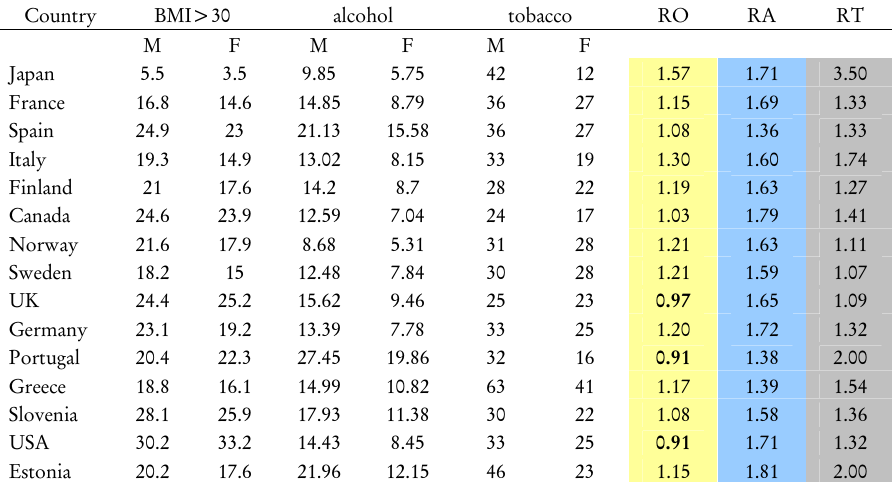
Health Risk Factors, (WHO